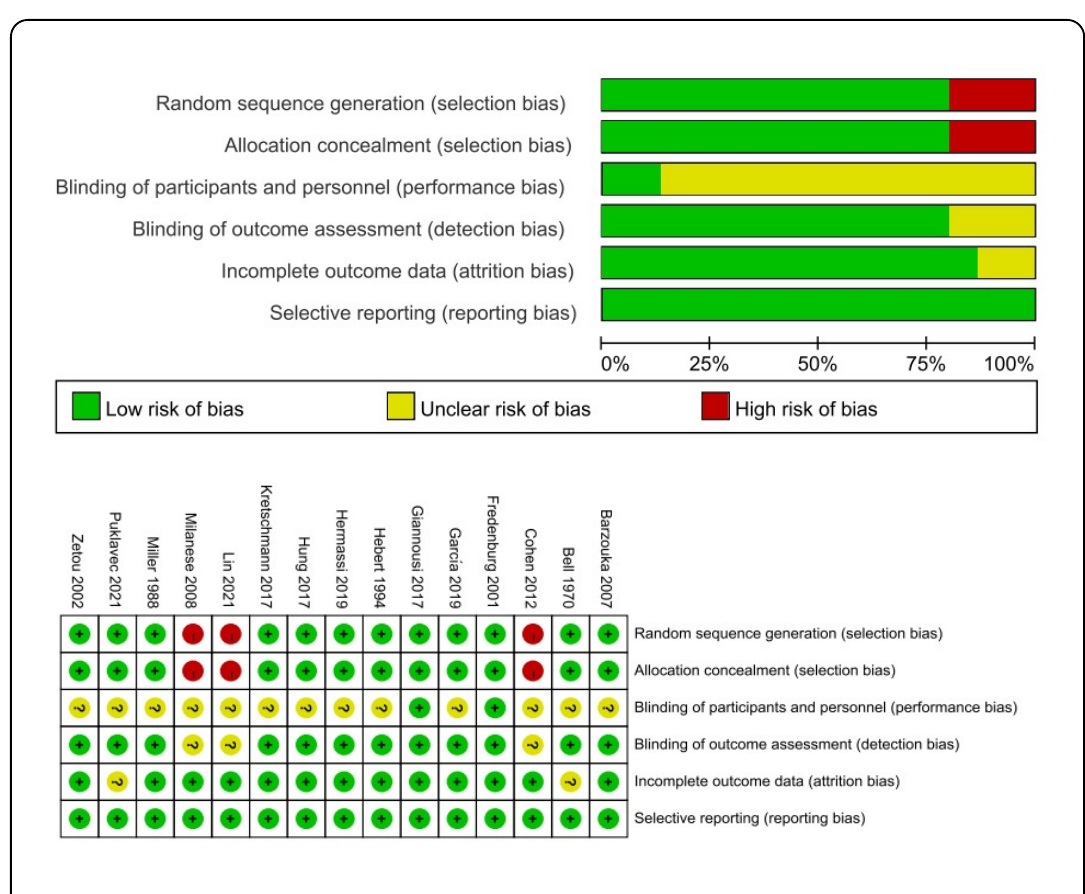
Figure 2. Risk of bias assessment. Zetou (2002) [39], Puklavec (2021) [20], Miller (1988) [36], Milanese (2008) [40], Lin (2021) [19], Kretschmann (2017) [44], Hung (2017) [43], Hermassi (2019) [18], Hebert (1994) [37], Giannousi (2017) [42], García (2019) [17], Fredenburg (2001) [38], Cohen (2012) [41], Bell (1970) [35], Barzouka (2007) [21].